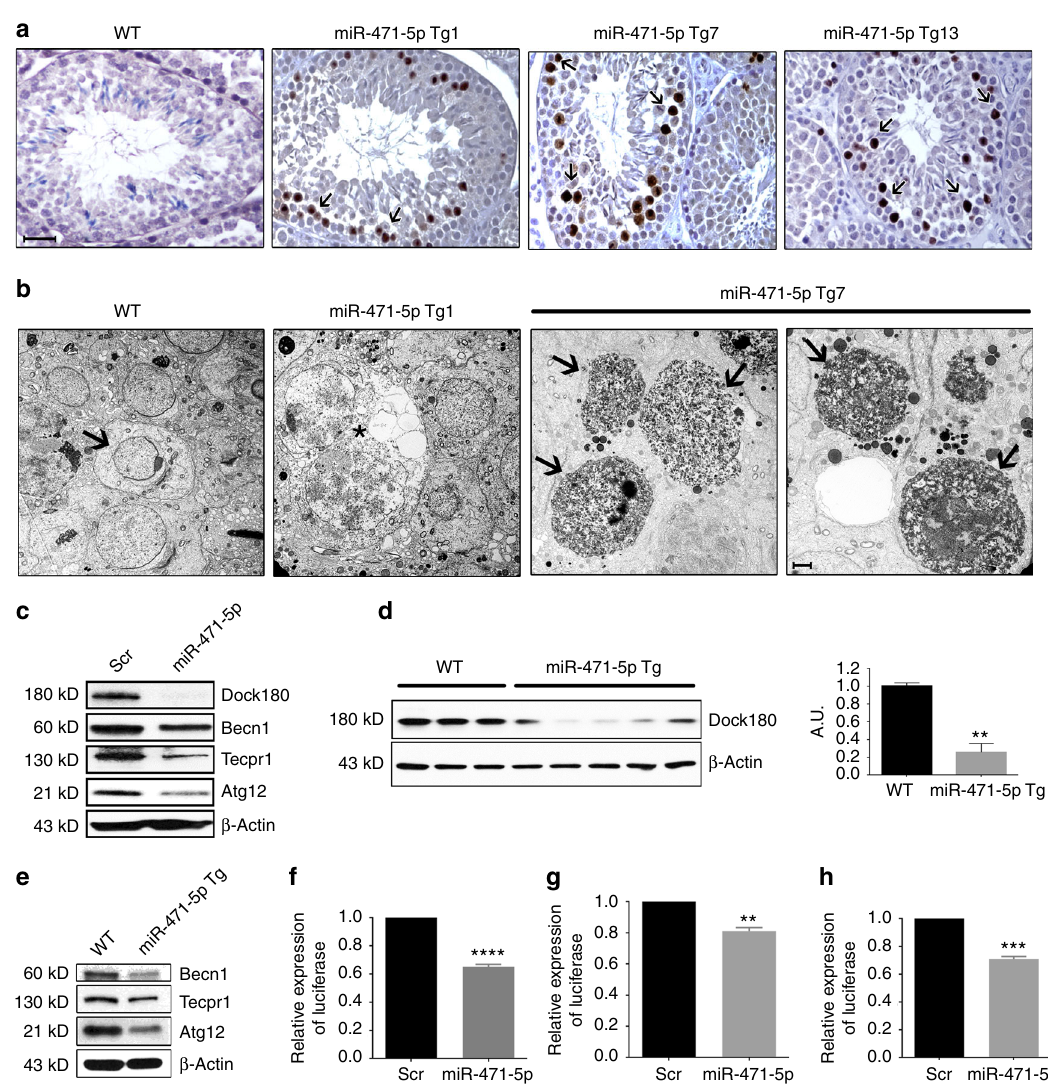
Fig. 2 MiR-471-5p regulates germ cell apoptosis/necrosis and targets autophagy-associated proteins in Sertoli cells. a TUNEL analysis of testes sections from three miR-471-5p transgenic lines (Tg1, Tg7, and Tg13) showed signi fi cantly increased number of apoptotic/necrotic germ cells. b Electron microscopic observation of miR-471-5pTg mice testis showed drastically increased germ cell apoptosis/necrosis in two independent lines Tg1 and Tg7. Asterisks (*) indicate presence of large vacuoles in miR-471-5pTg mice. Black arrows in miR-471-5p Tg7 indicate apoptotic germ cells. WT testis showed normal acrosome and spermatogenesis. c Western blot analysis on 15p1 Sertoli cells transfected with scramble ( Scr ) or miR-471-5p mimic ( miR-471-5p ) using antibodies against Dock180 (1:1000), Becn1 (1:1000), Tecpr1 (1:1000), and Atg12 (1:1000). Gel photograph is representative of three independent experiments. Bar graphs showing quanti fi cation of band intensities are shown in Supplementary Fig. 3b. d Western blot analysis on total testis from WT and miR-471-5pTg using antibody against Dock180. β -Actin (1:50,000) was used as a loading control. Gel photograph is representative of three independent experiments (WT: n = 3 mice per experiment; miR-471-5pTg: 5 mice per experiment). Band intensities were quanti fi ed using ImageJ software, ** p = 0.0016, two-tailed unpaired student t -test. e Western blot analysis on puri fi ed Sertoli cells isolated from WT and miR-471-5p Tg mice using antibodies against indicated proteins. Gel photograph is representative of three independent experiments. Puri fi ed Sertoli cells were pooled from six each of WT and miR-471-5p Tg mice/experiment. Quanti fi cation of band intensities are shown in Supplementary Fig. 3e. f – h TM4 Sertoli cells were